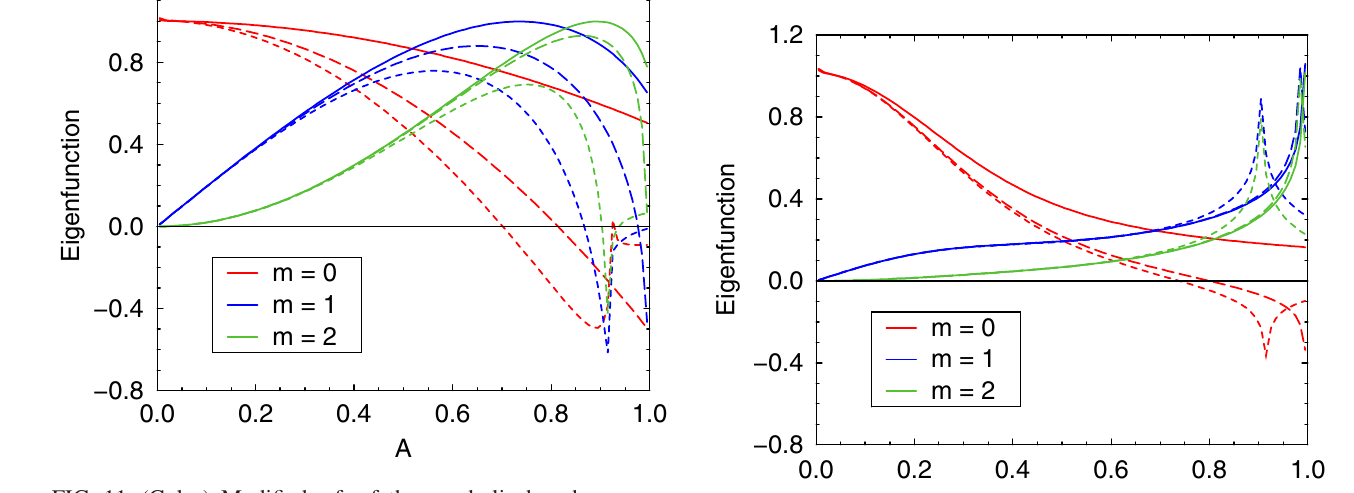
FIG. 11. (Color) Modified e.f. of the parabolic bunch vs nor- malized synchrotron amplitude (three radial modes for each multipole).